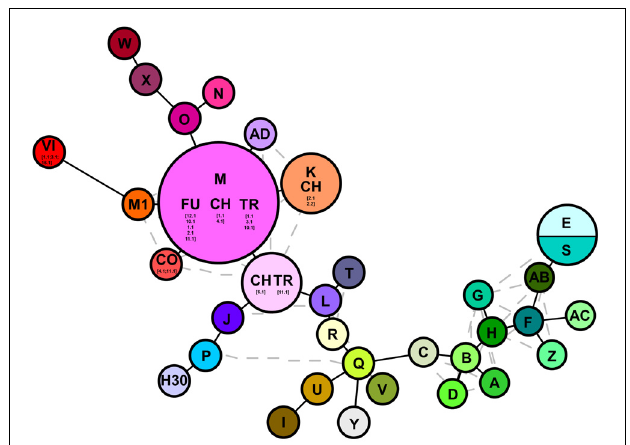
FIGURE 2 | Haplotype networks analysis based on cpDNA markers (trnT-trnL/rbcL-psaI). Letters denote haplotypes as reported in Supplementary Table S1; gray lines represent alternative connection separating the different haplotypes. Numbers depict the samples analyzed in this study as reported in Supplementary Table